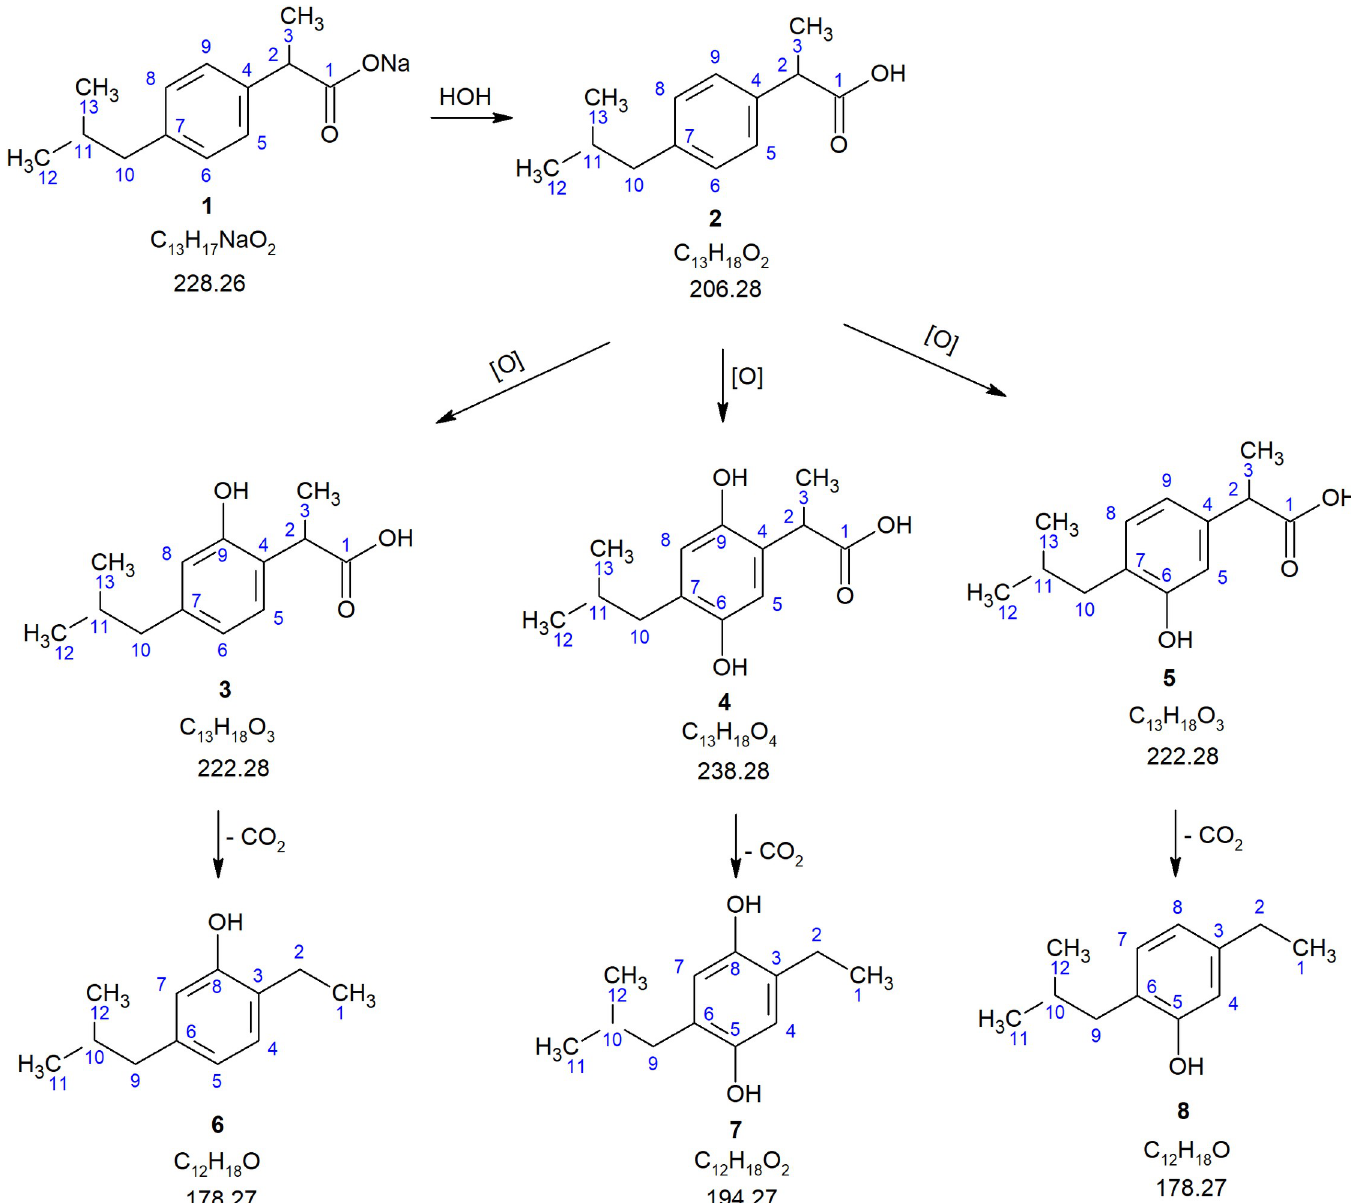
Fig 4. Proposed scheme of IBP biotransformation by R . cerastii IEGM 1278. 1 –ibuprofen sodium salt; 2 –ibuprofen; 3 –9-hydroxy ibuprofen; 4 –6,9-dihydroxy ibuprofen; 5 –6-hydroxy ibuprofen; 6 –decarboxylated derivative of 9-hydroxy ibuprofen; 7 –decarboxylated derivative of 6,9-dihydroxy ibuprofen; 8 –decarboxylated derivative of 6-hydroxy ibuprofen. The numbering of IBP atoms proposed by Preskar et al. is used [88].